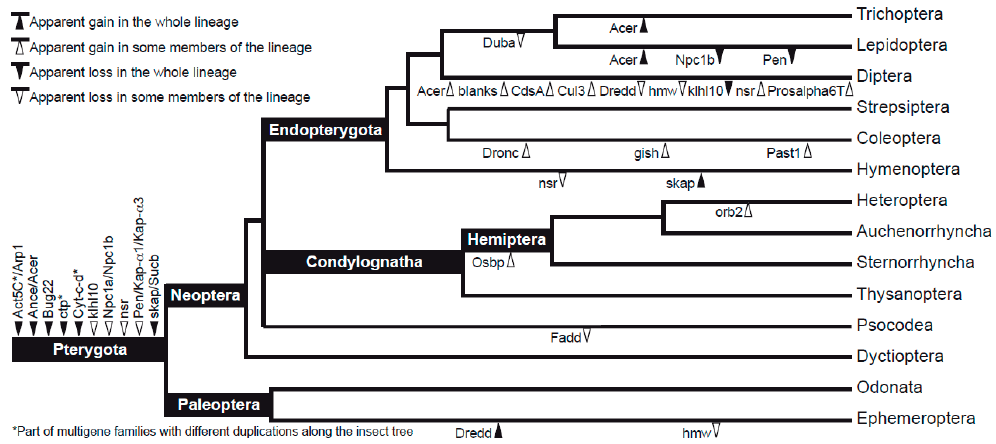
Figure 3. Schematic consensus phylogeny of insects (drawn from trees in [56–58]) showing the inferred evolutionary gains and losses of sperm individualization genes for major insect lineages.